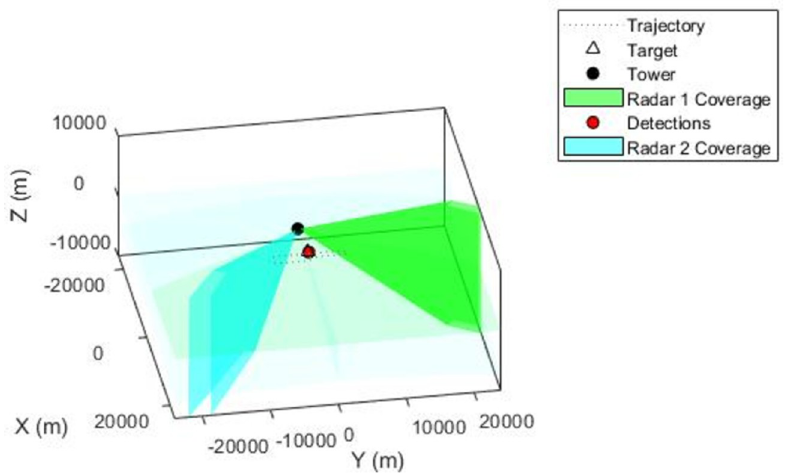
Fig 4. Second radar mounted on the tower. With it scanning detection angle and field of view of (4,45).